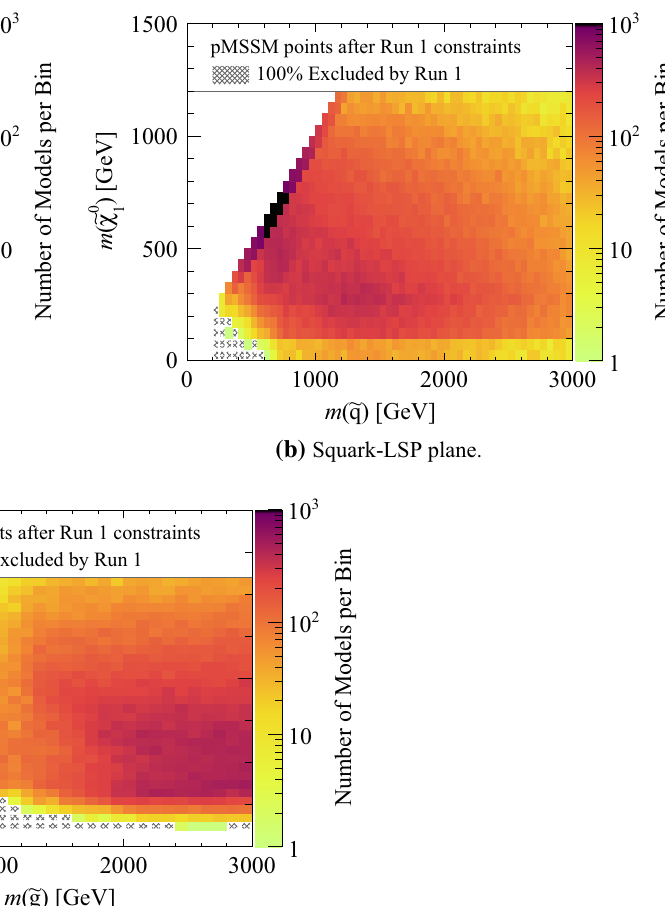
(c) Gluino-squark plane. ond generations. The colour scale has a maximum of 1000 models per Fig. 13 Number of models that survived Run 1 ATLAS constraints, bin, indicated by black . Hatched grey regions indicate mass bins where before applying our Run 2 analyses. White regions indicate no models. 100% of the points are excluded by Run 1 searches in Ref. [53]. Mod- This is projected into the gluino–LSP ( upper left ), squark–LSP ( upper right ), and gluino–squark ( lower ) mass planes. Here m ( ˜ q ) is the mass els with long-lived gluinos, squarks or sleptons are removed from of the lightest left- or right-handed squark of either the first or sec-